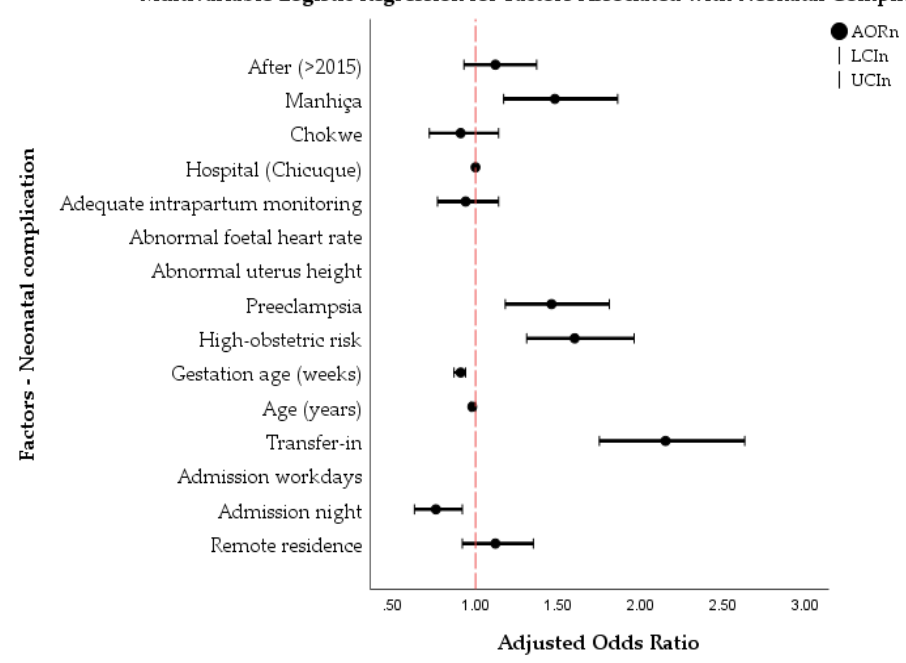
Figure A2. Factors Associated with First Caesarean.